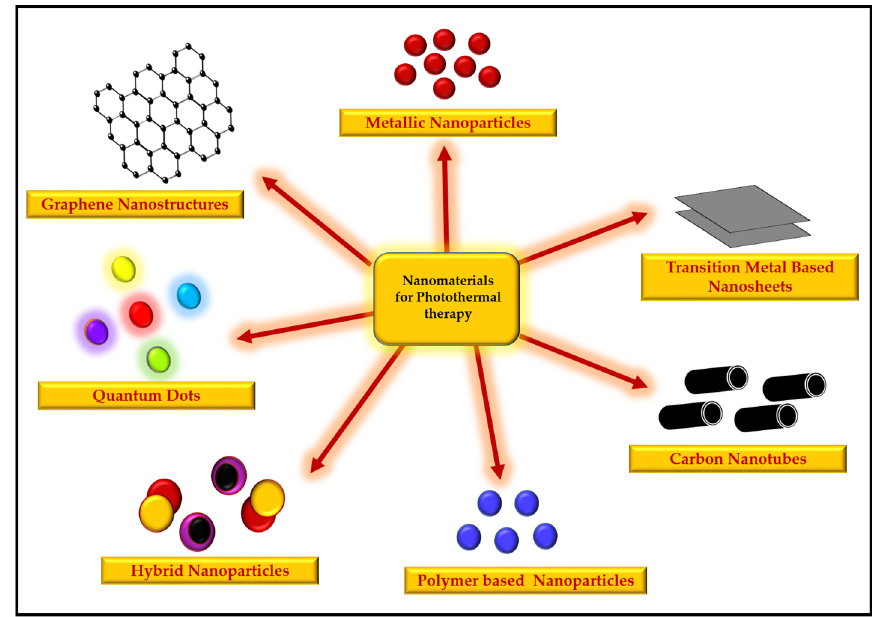
Figure 3. Types of nanomaterials used for photothermal therapy.